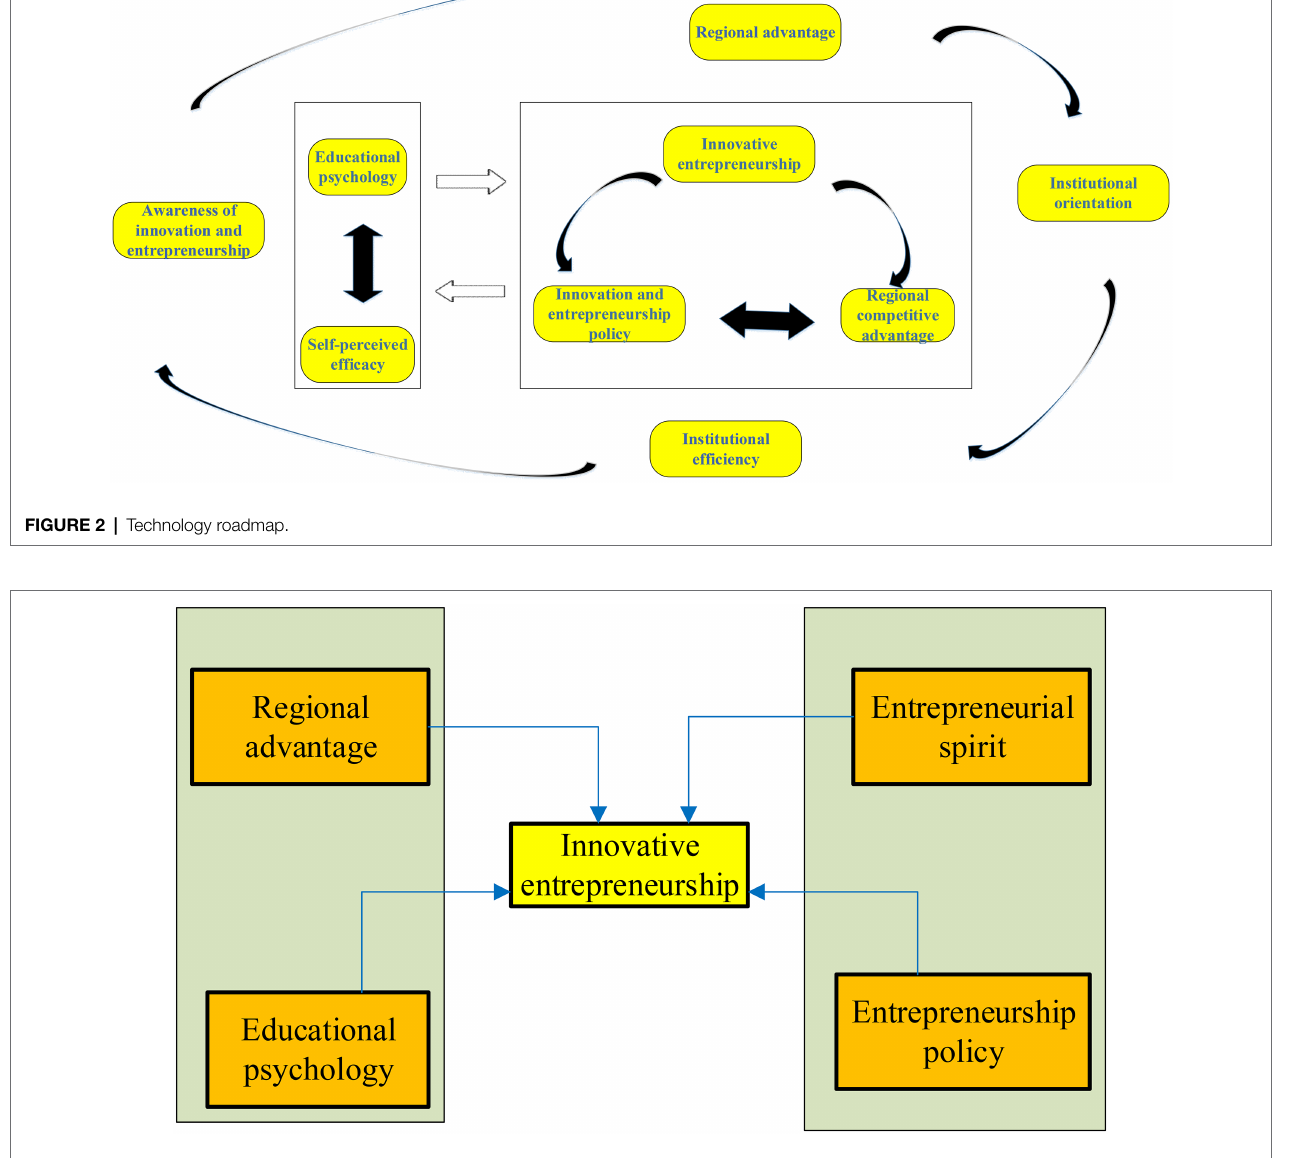
FIGURE 3 | User intention research